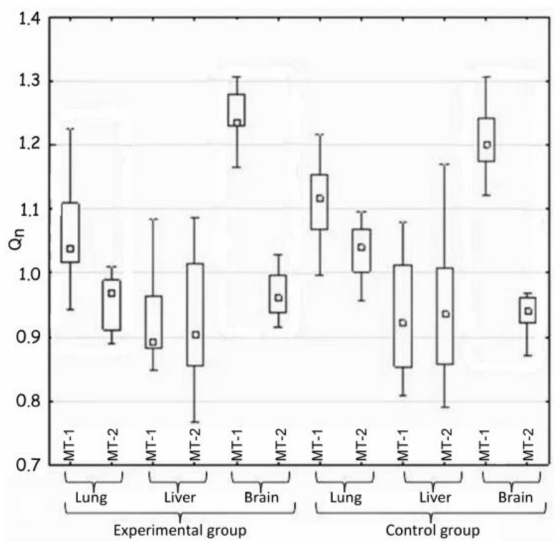
Figure 2. Comparison of the expression of MT-1 and Mt-2 genes in the same tissue